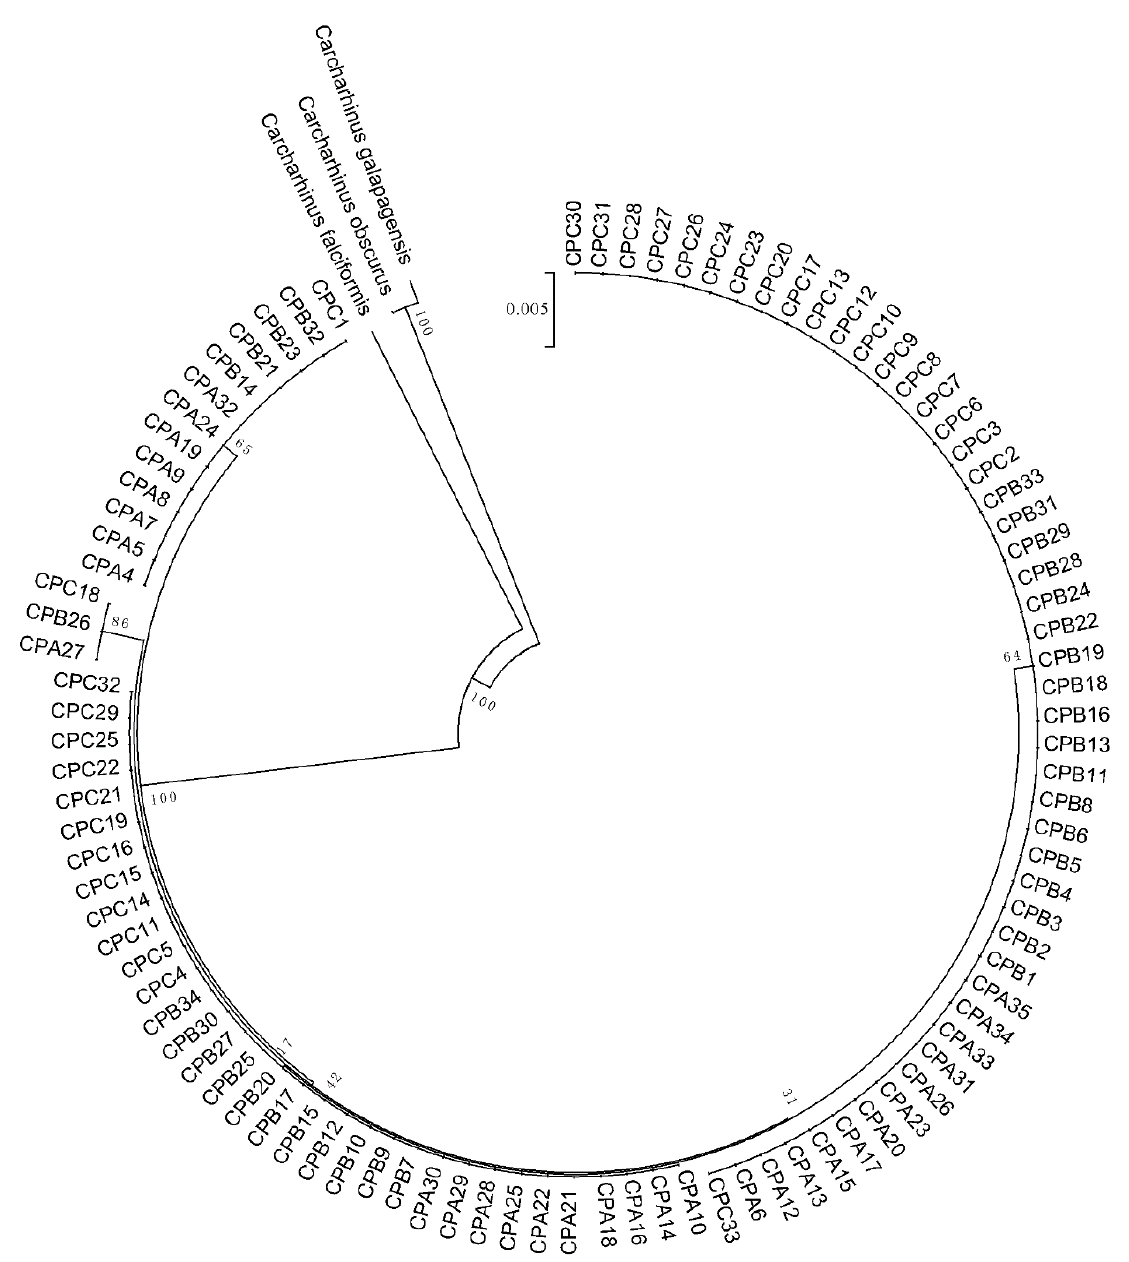
Figure 3. Neighbor-joining tree obtained based on 98 individual blue sharks samples from the Pacific Ocean. Table 4. Parameters for mismatch distribution and Fu’s test for blue sharks in the Pacific Ocean. Region